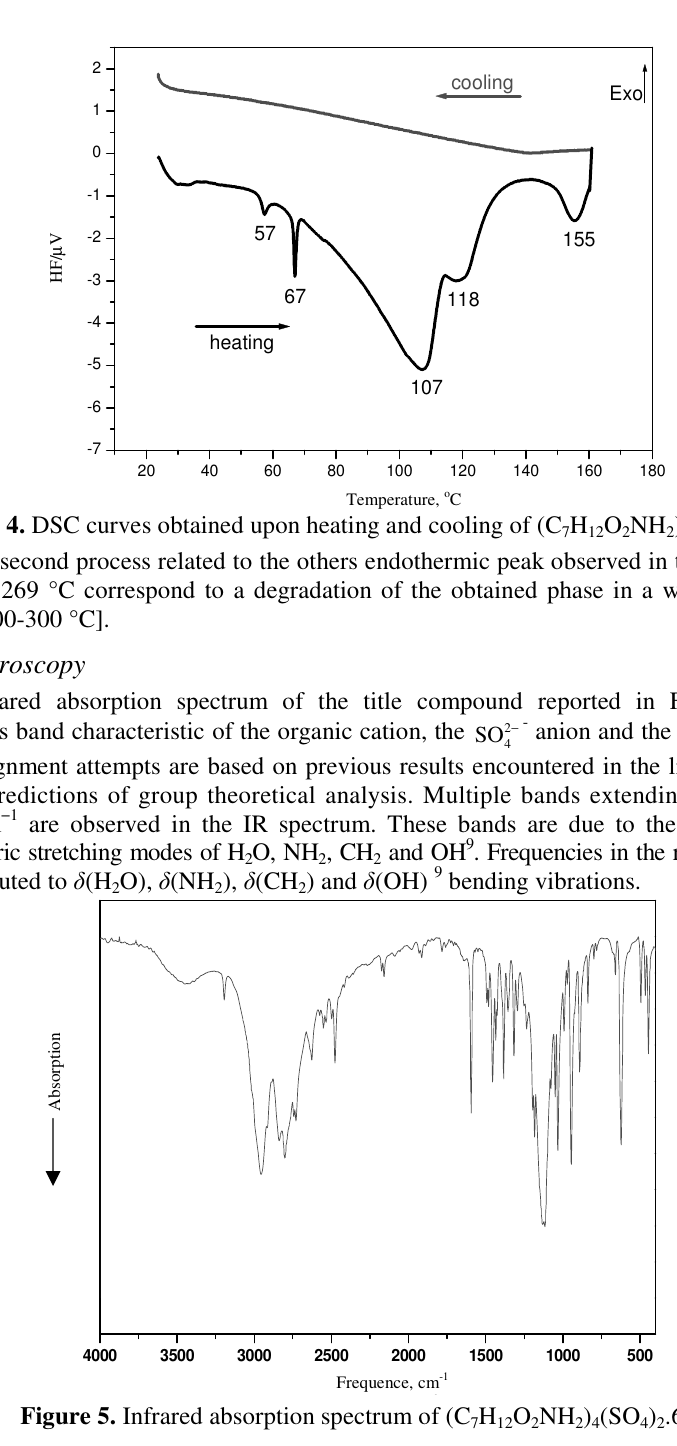
H O NH ) (SO ) .6H 7 12 2 2 4 4 2 2